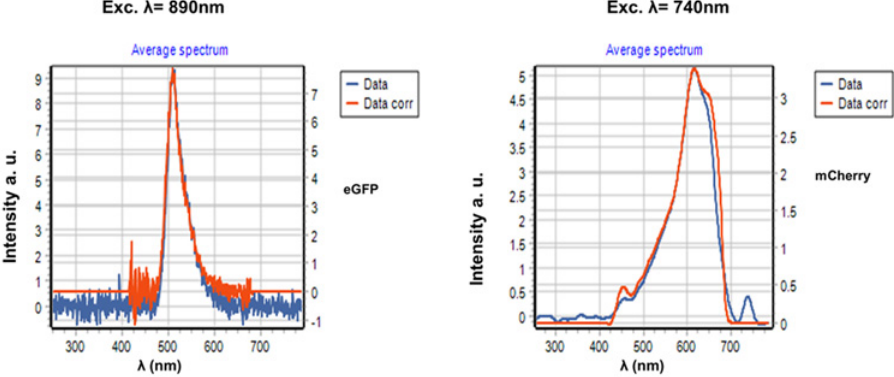
Fig 6. Emission spectrum of EGFP and mCherry in a region of the sample with no AuNP. The excitation wavelengths were chosen to maximally excite each of the fluorophores, 890nm and 740nm,